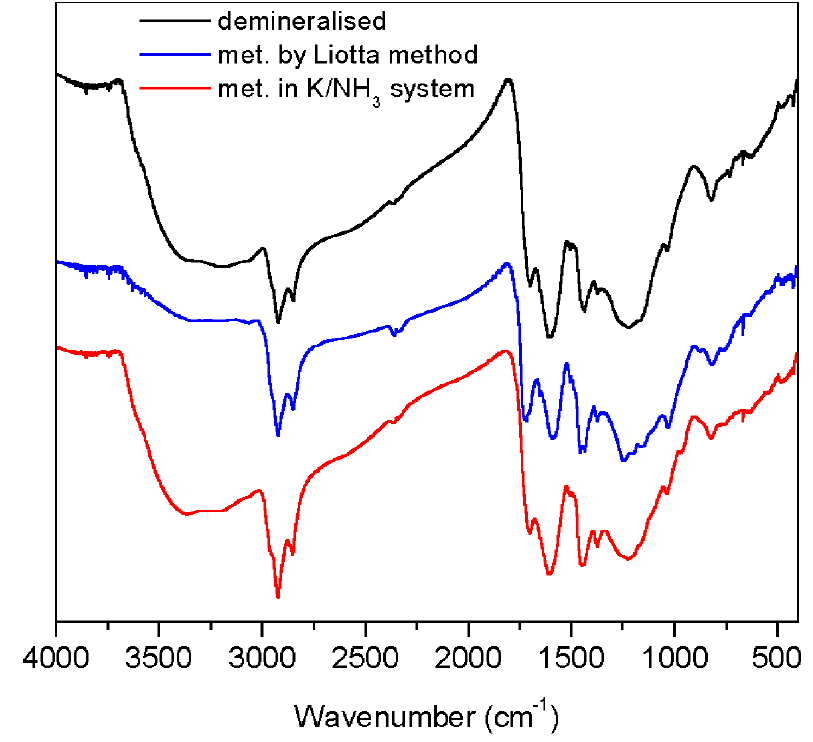
Fig. 3 IR spectra of CH 2 Cl 2 residues of Mequinenza